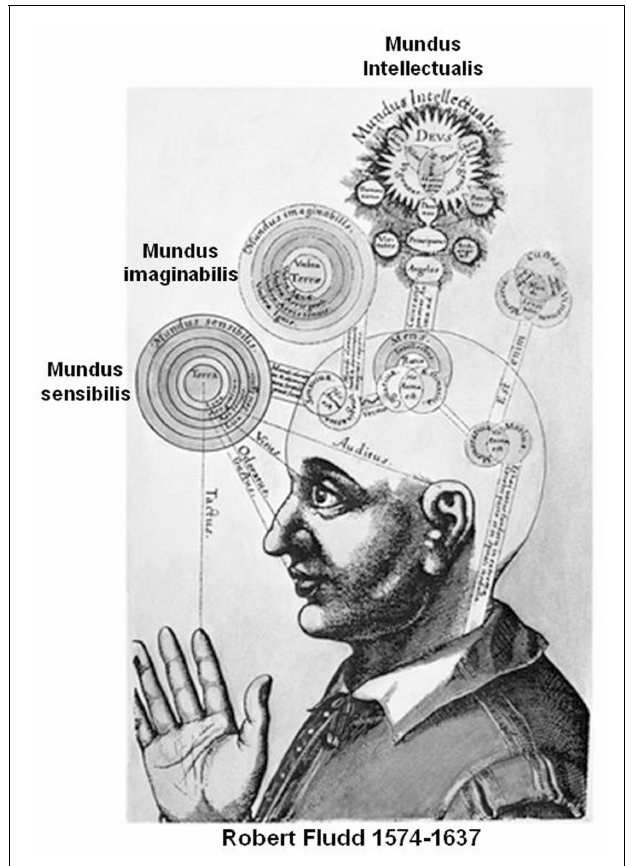
FIGURE 5 | Inspiring drawing from Robert Fludd masterpiece ( Utriusque Cosmi, maiores scilicet et minores, metaphysica, physica atque technica Historia 1617–1621) . In agreement with our proposal the imagination process can be considered as Fludd’s mundus imaginabilis hence a process that can be entirely decoupled from the input of the external